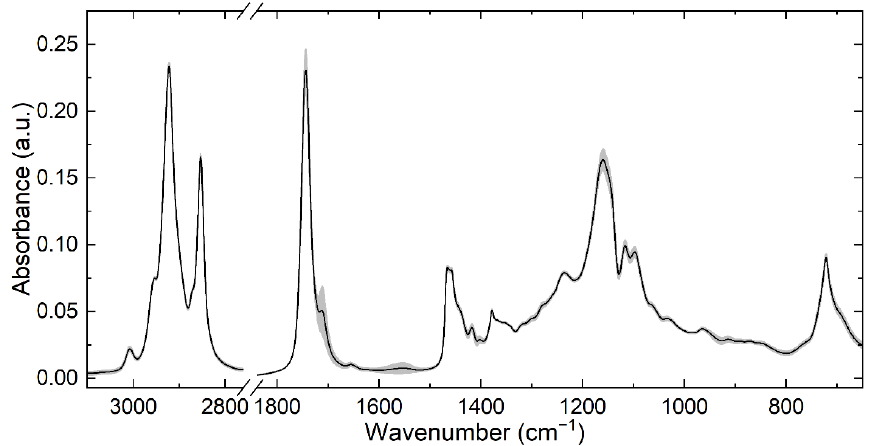
Figure 1. Mean spectrum (black line) of the recorded ATR-FTIR spectra of the separated lipid fraction of HM and variance (1 σ ) within the dataset of 50 samples (grey area).